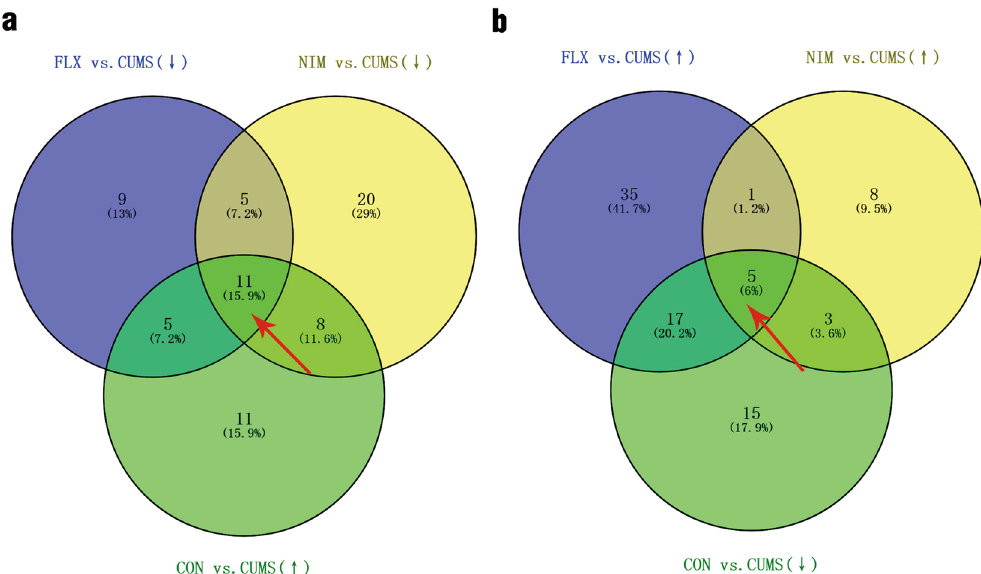
Figure 3. Venn diagram presents overlapping relationships and the numbers indicate differentially expressed protein counts. Overlapping regions of the Venn diagrams indicate differentially expressed proteins shared between or among corresponding groups. ( a ) The red short arrow indicates 11 overlappings differentially expressed proteins. Compared with the CUMS group, these proteins were downregulated by fluoxetine or nimesulide but upregulated in the CON group. ( b ) The red short arrow indicates 5 overlappings differentially expressed proteins. Compared with the CUMS group, these proteins were upregulated by fluoxetine or nimesulide but downregulated in the CON group.